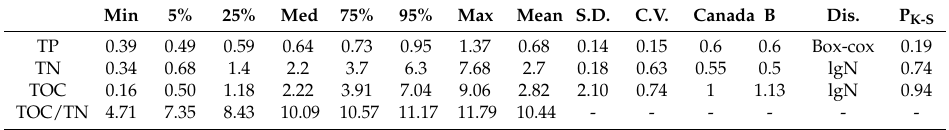
Table 1. Summary statistics of nutrients in the surface sediments of Nansi